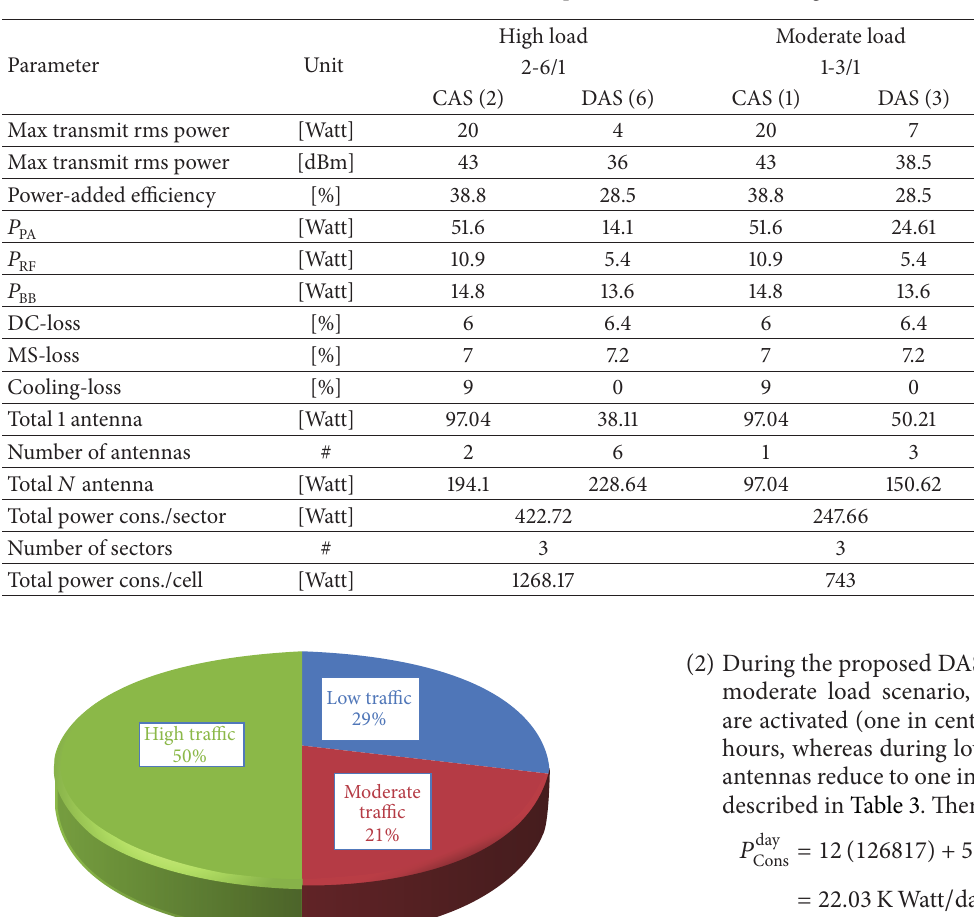
Table 3: Power consumption of different DAS configurations.